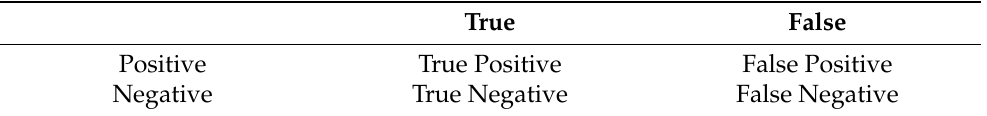
Table 4. Confusion Matrix